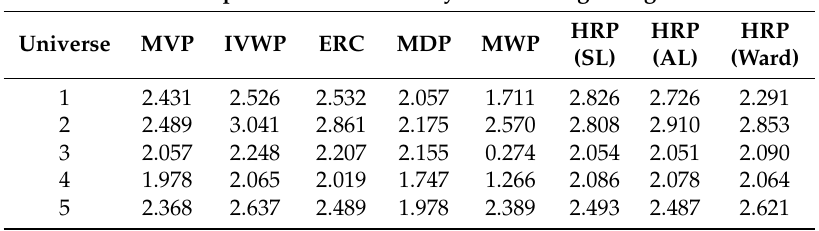
Table 12. The annual Sharpe ratio for the different allocation methods when the portfolio is rebalanced monthly and SMPL is used to forecast the covariance